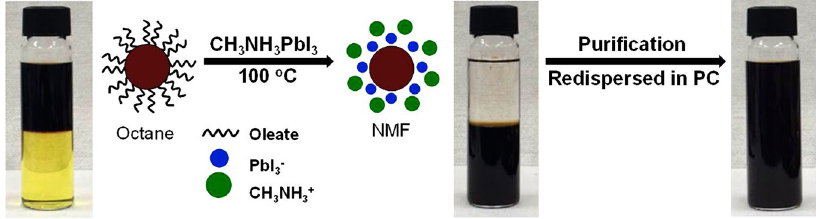
Figure 1. Illustration of phase transfer of PbS QDs from nonpolar solvent (octane) to polar solvent (NMF) induced by ligand exchange of oleates with CH 3 NH 3 PbI 3 (MAPbI 3 ). Acetone and PC were used for purification and redispersion,